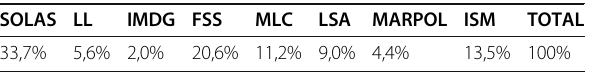
Table 8 The comparison of International Maritime Regulations by detention